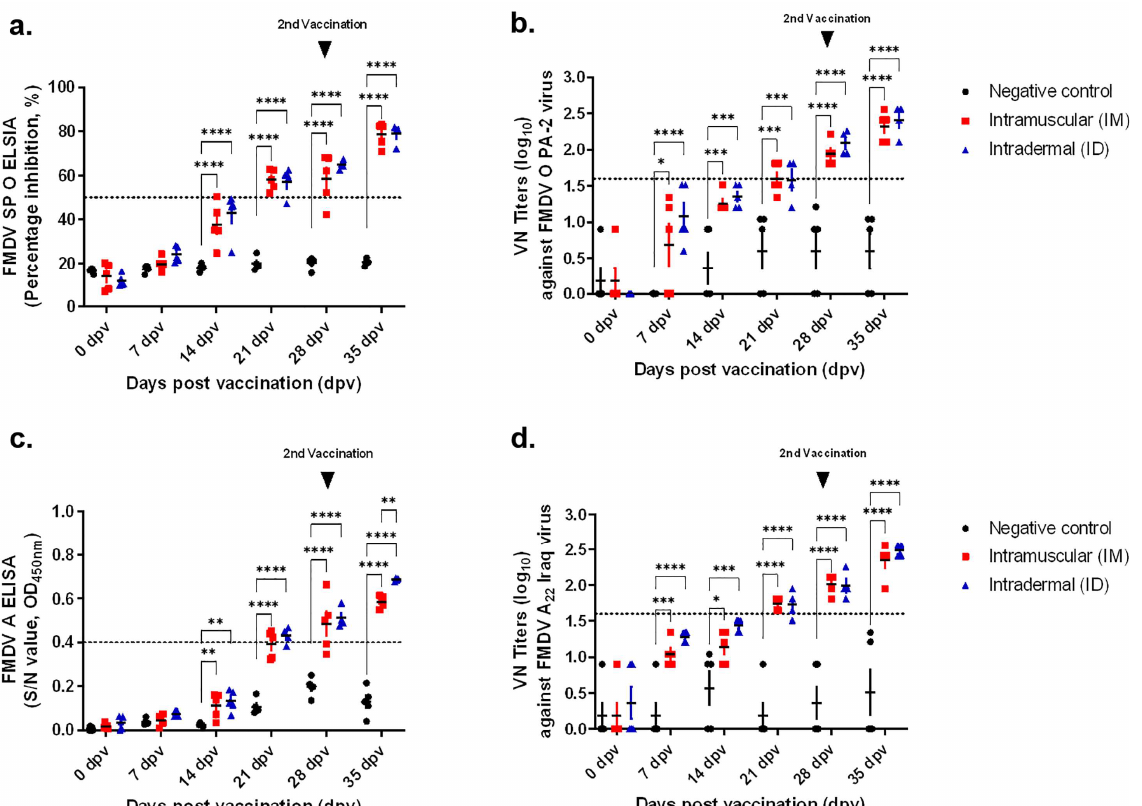
Figure 3. Comparison of serological response after vaccination of swine with IM and ID